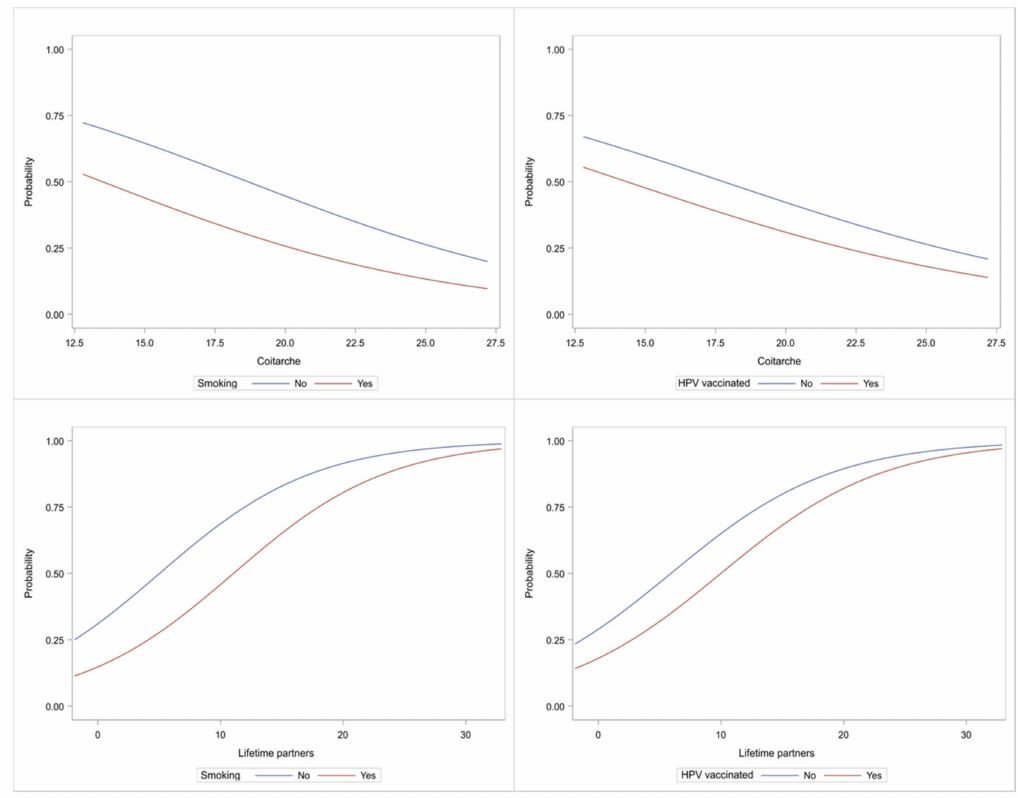
Figure 3. Characteristic curves showing the probability for DNA positivity. Top row: age of first sexual intercourse; Bottom row: number of sex partners; Left column: smoking; Right column: vaccination. Vertical axis shows the probability for DNA